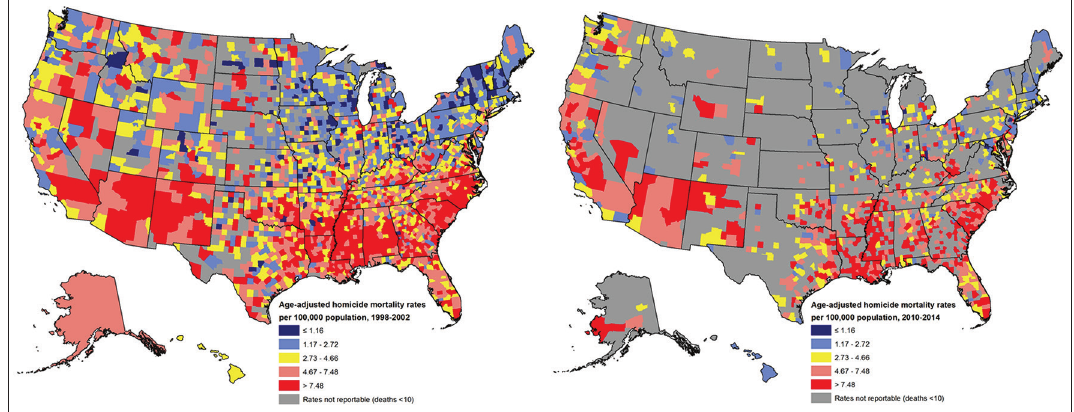
Fig ure 21. Age-Adjusted Homicide Rates per 100,000 Population for the United States (3,143 Counties), 1998-2002 and 2010-2014 Source: Derived from the 1998-2014 National Vital Statistics